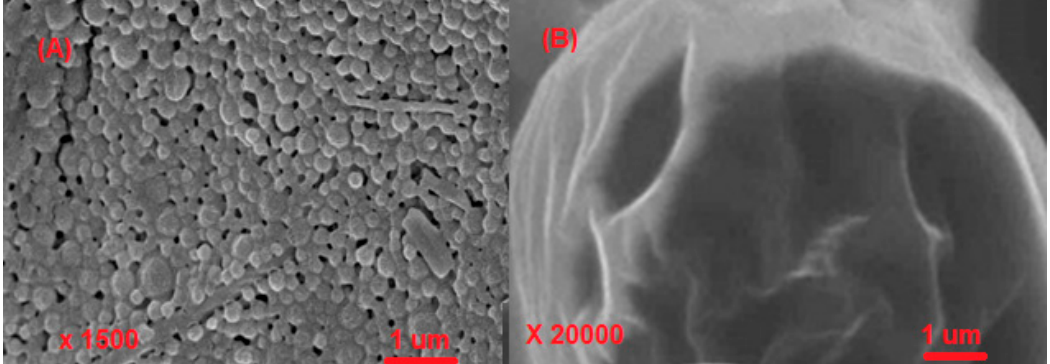
Figure 3. FESEM images of docetaxel ‐ loaded PLGA–TPGS/Poloxamer 235 nanoparticles and microparticles. ( A ) nanoparticles; ( B ) microparticles [41].